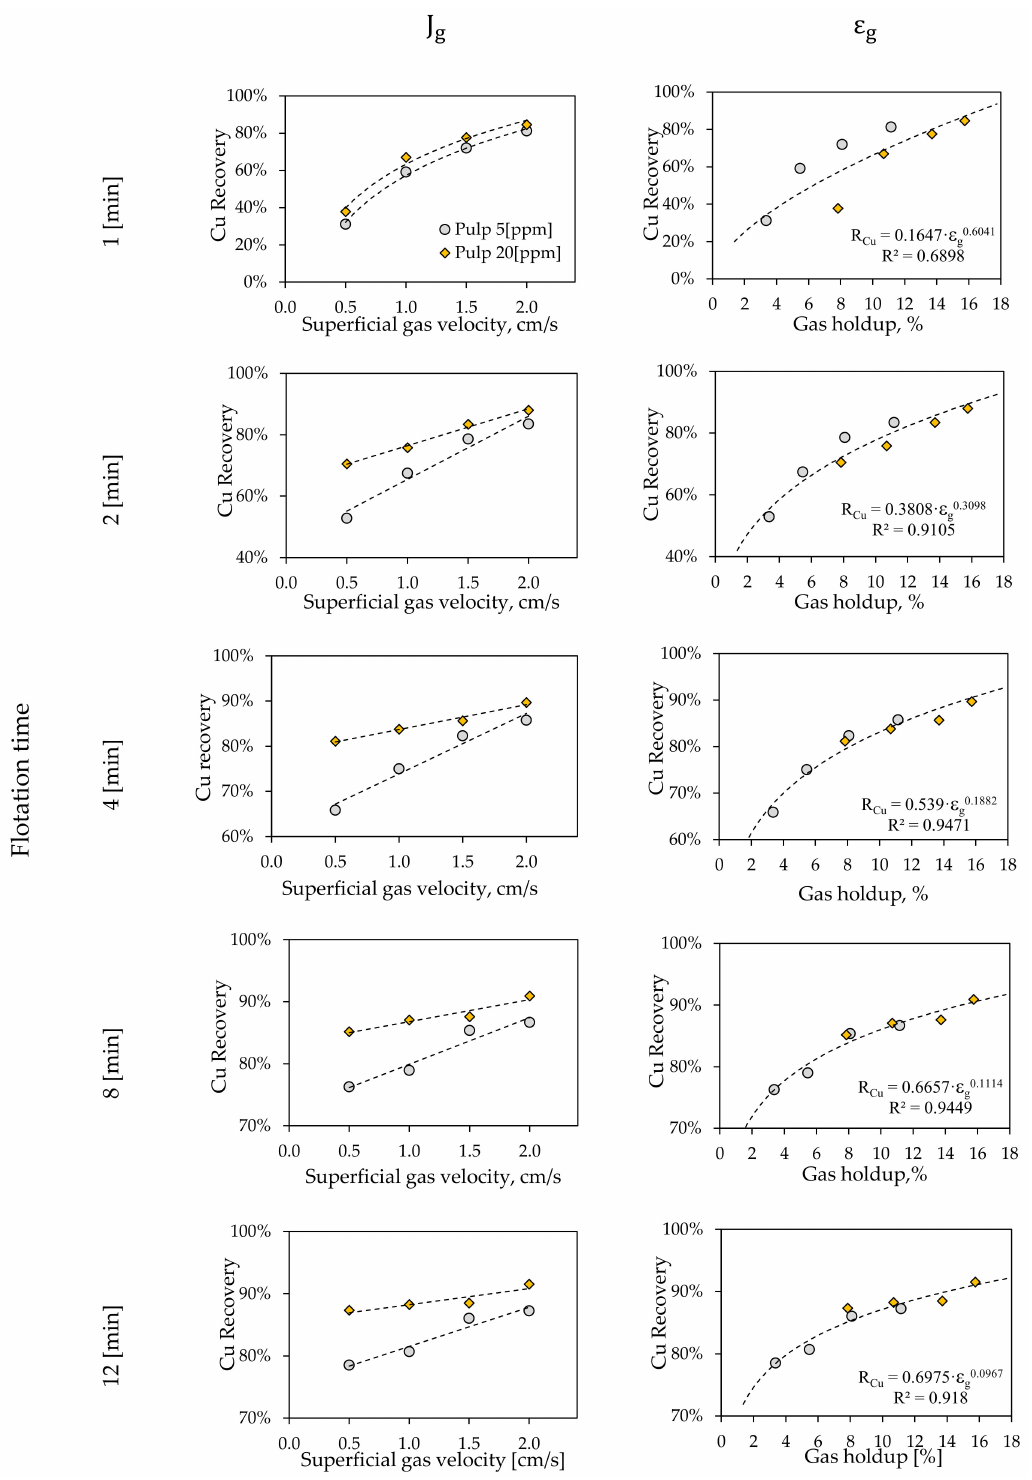
Figure 13. Copper recovery for batch flotation times as a function of superficial gas velocity (first column) and gas holdup (second